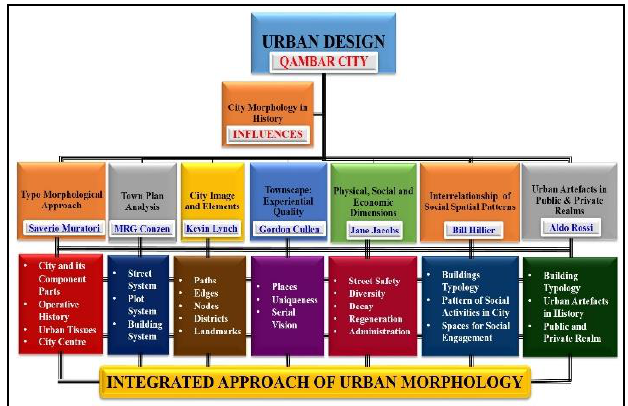
Fig. 1. Integrated urban morphology approach to investigate urban design of